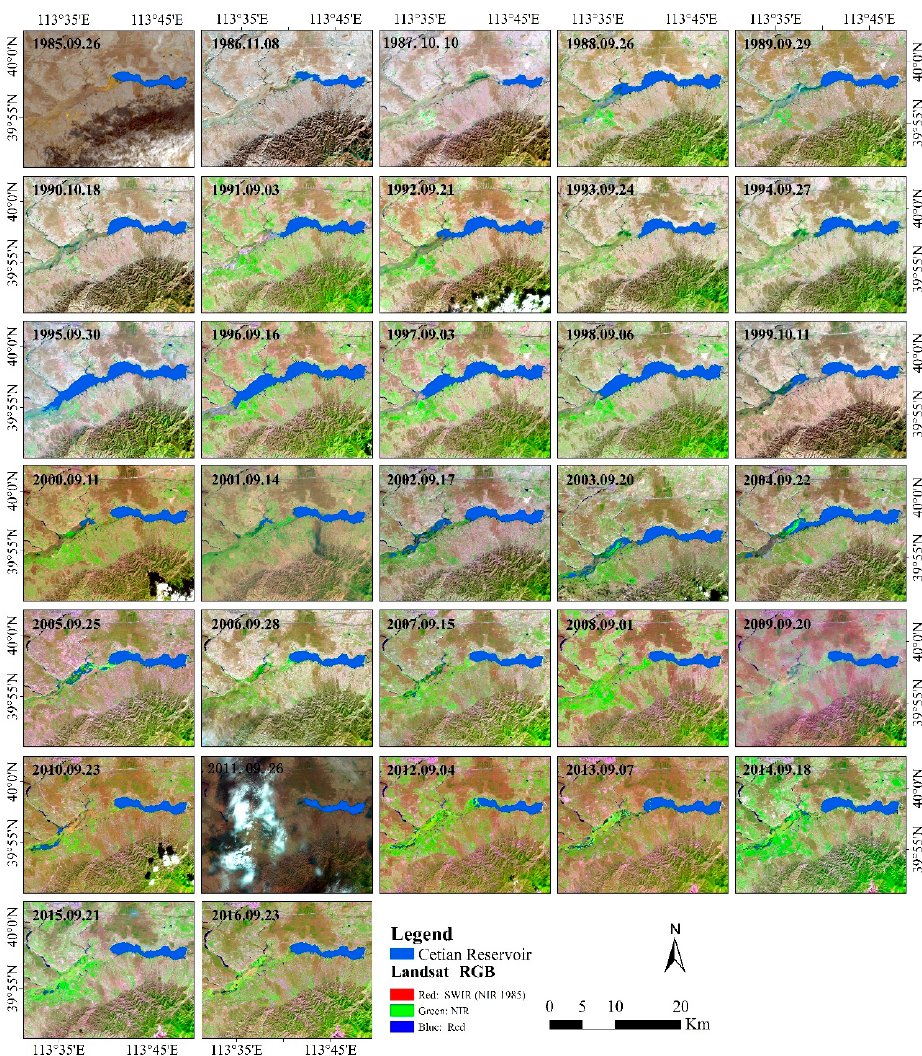
Figure A3. Water extent in Cetian reservoir superimposed on Landsat-series images.